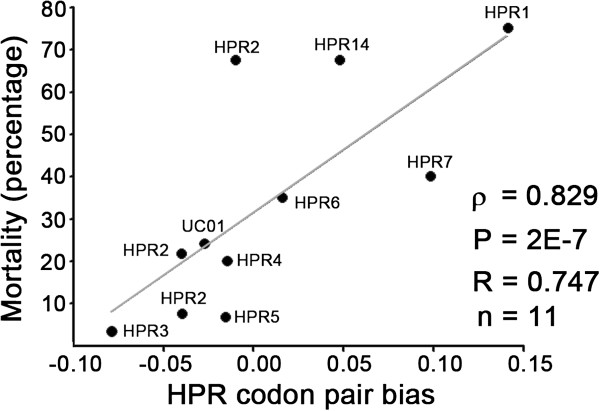
Relationship between virulence and codon-pair bias (CPB). The figure shows the relationship between mortality of ISAV1 and ISAV11 reported by Mjaaland, and the CPB values reached by their HPR regions. The statistical validity of the correlation was determined by the non-parametric Spearman rank order test.